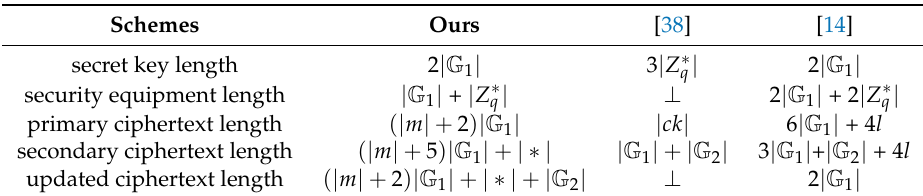
Table 3. Communication cost